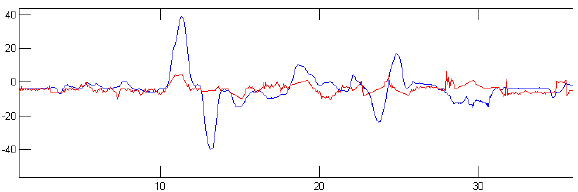
Figure 14. Errors observed on Roll: 3DCloud in red, reference in